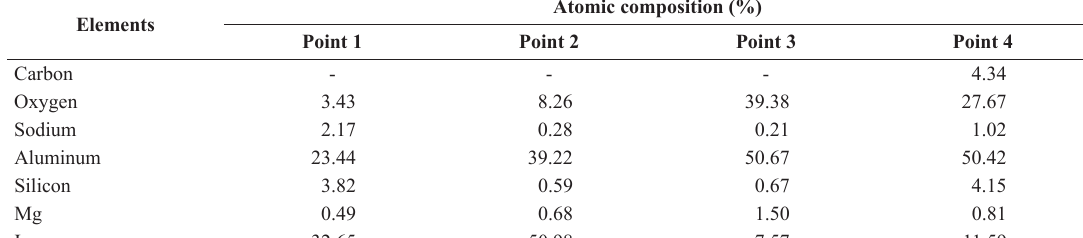
Table 2. Atomic composition, as determined by EDS, in four points randomly chosen on coatings produced by PEO from red mud electrolytes. Elements